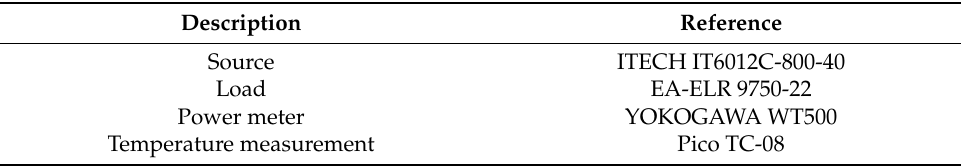
Table A1. Equipment used for the measuring of the experimental